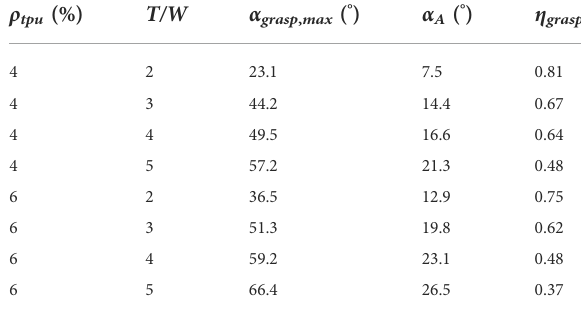
TABLE 5 Ef fi ciency comparison of the fl exible UAV η grasp during the grasping maneuver for different in fi ll rates ρ tpu and thrust-to- weight ratios T/W